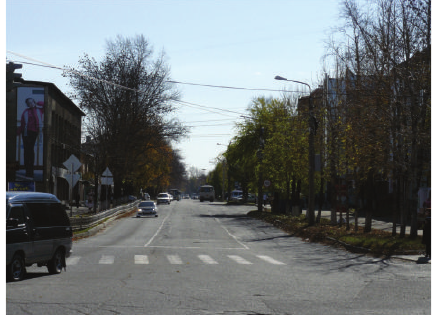
Figure 12: Square in Birobidzhan (zone 3).